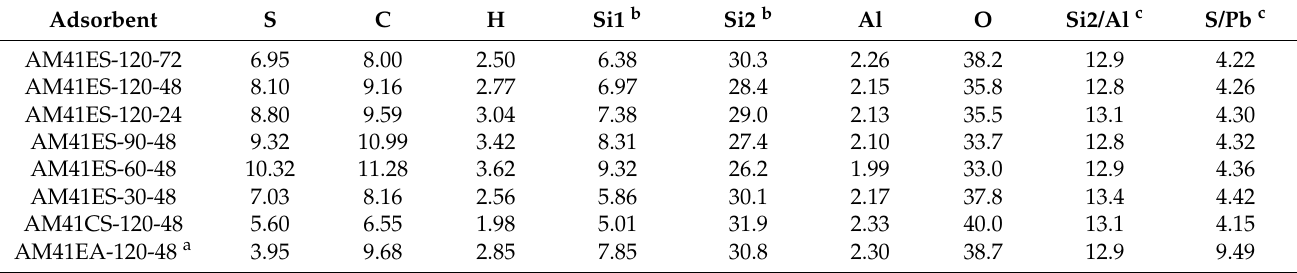
Figure 11 . Experiment data for Pb(II) removal and fitted isotherms for ( a ) AM41ES-120-72, AM41ES-120-48, and AM41ES-120-24, ( b ) AM41ES-120-48, AM41ES-90-48, AM41ES-60-48, and AM41ES-30-48, ( c ) AM41ES-120-48 and AM41CS-120-48, and ( d ) AM41ES-120-48 and AM41EA-120-48. Experimental condition s : adsorption temperature T = 25 °C, adsorbent dose m = 50 mg, solution volume V = 50 mL, contact time t = 200 min, pH = 6, and initial Pb(II) concentration C 0 = 20, 40, 60, 80, 100, 130, 160, and 200 mg/L. Table 7. Element composition (wt.%) of adsorbents investigated in this study.